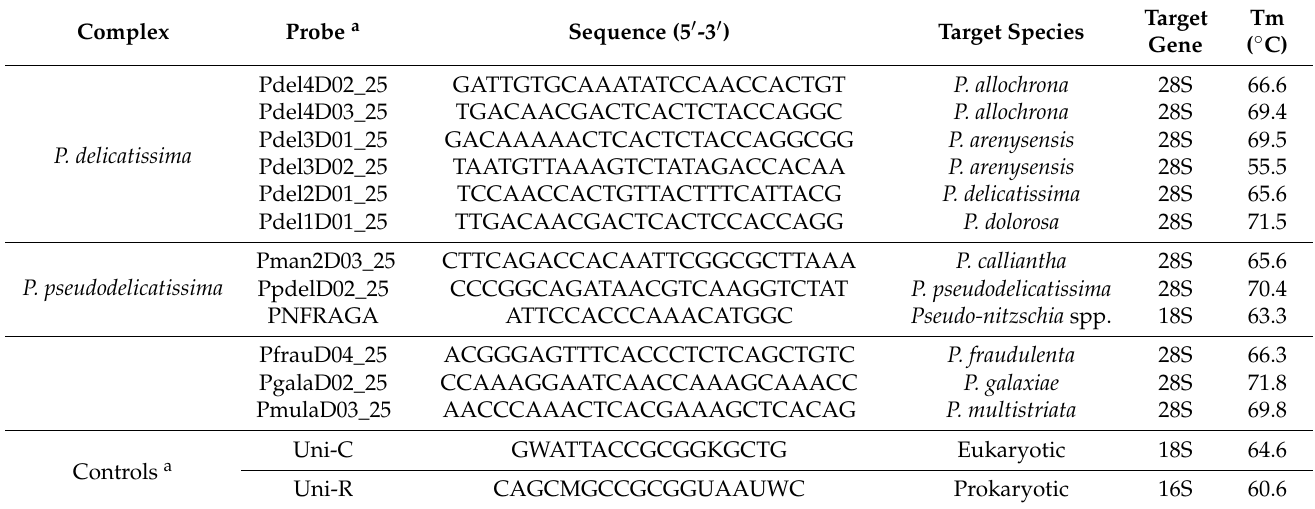
Table 1. Oligonucleotide probes used for Pseudo-nitzschia WC-FISH. The table shows the complex species, name probe, sequence, target species, target genes, and melting temperature (Tm).